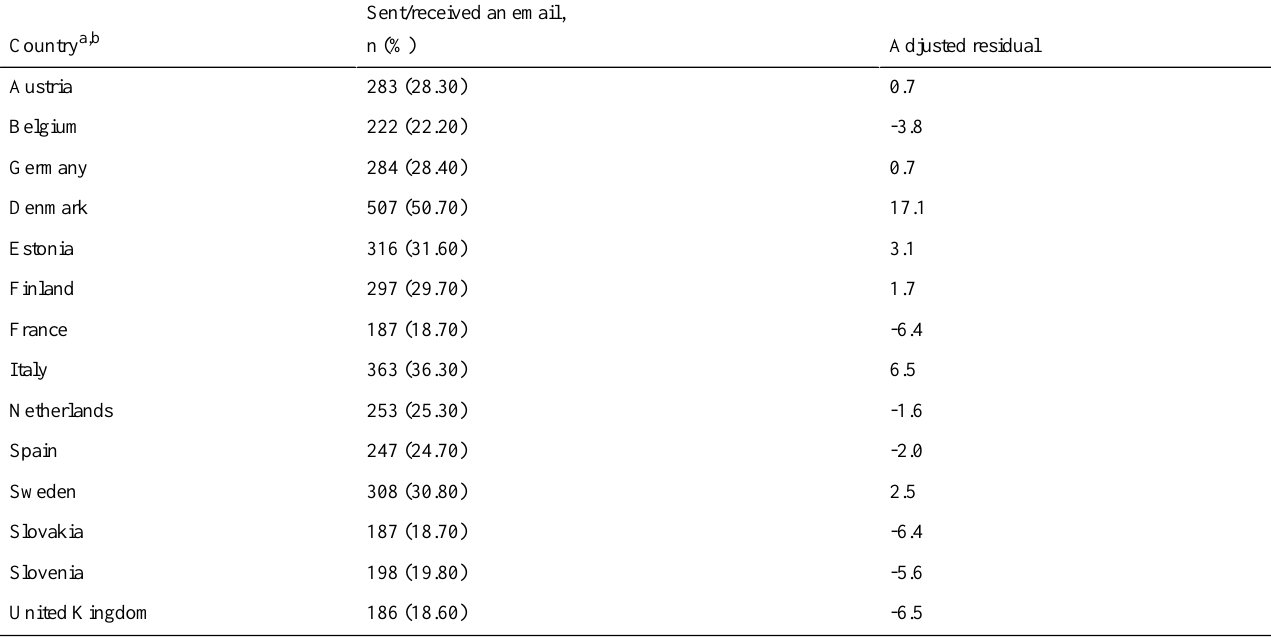
Table 4. Sent/received an email from your doctor, nurse, or health care organization, by